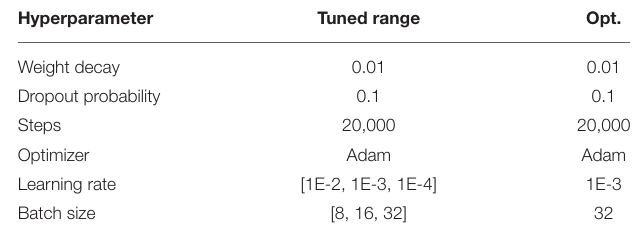
TABLE 3 | Hyperparameter setting for T5 small.